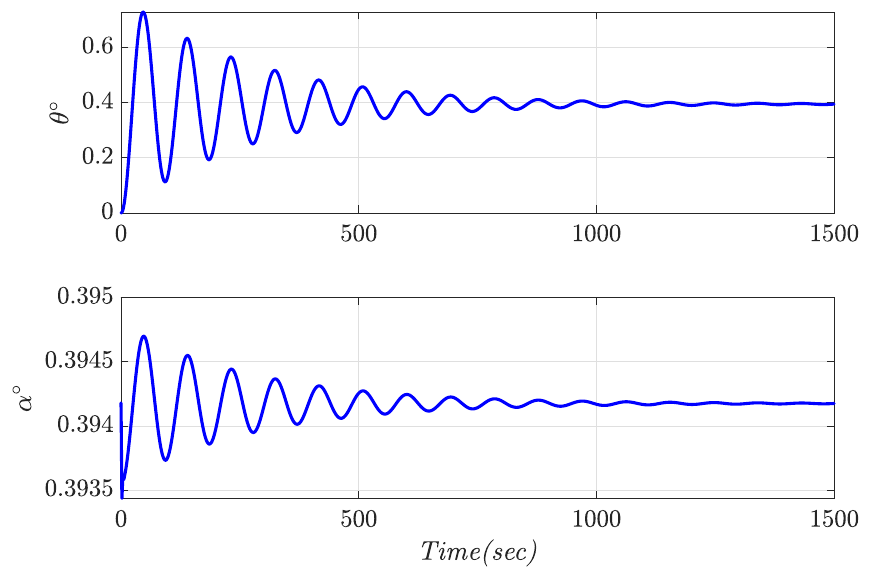
Figure 7. The angle of attack and pitch angle variation in the vicinity of trim conditions.